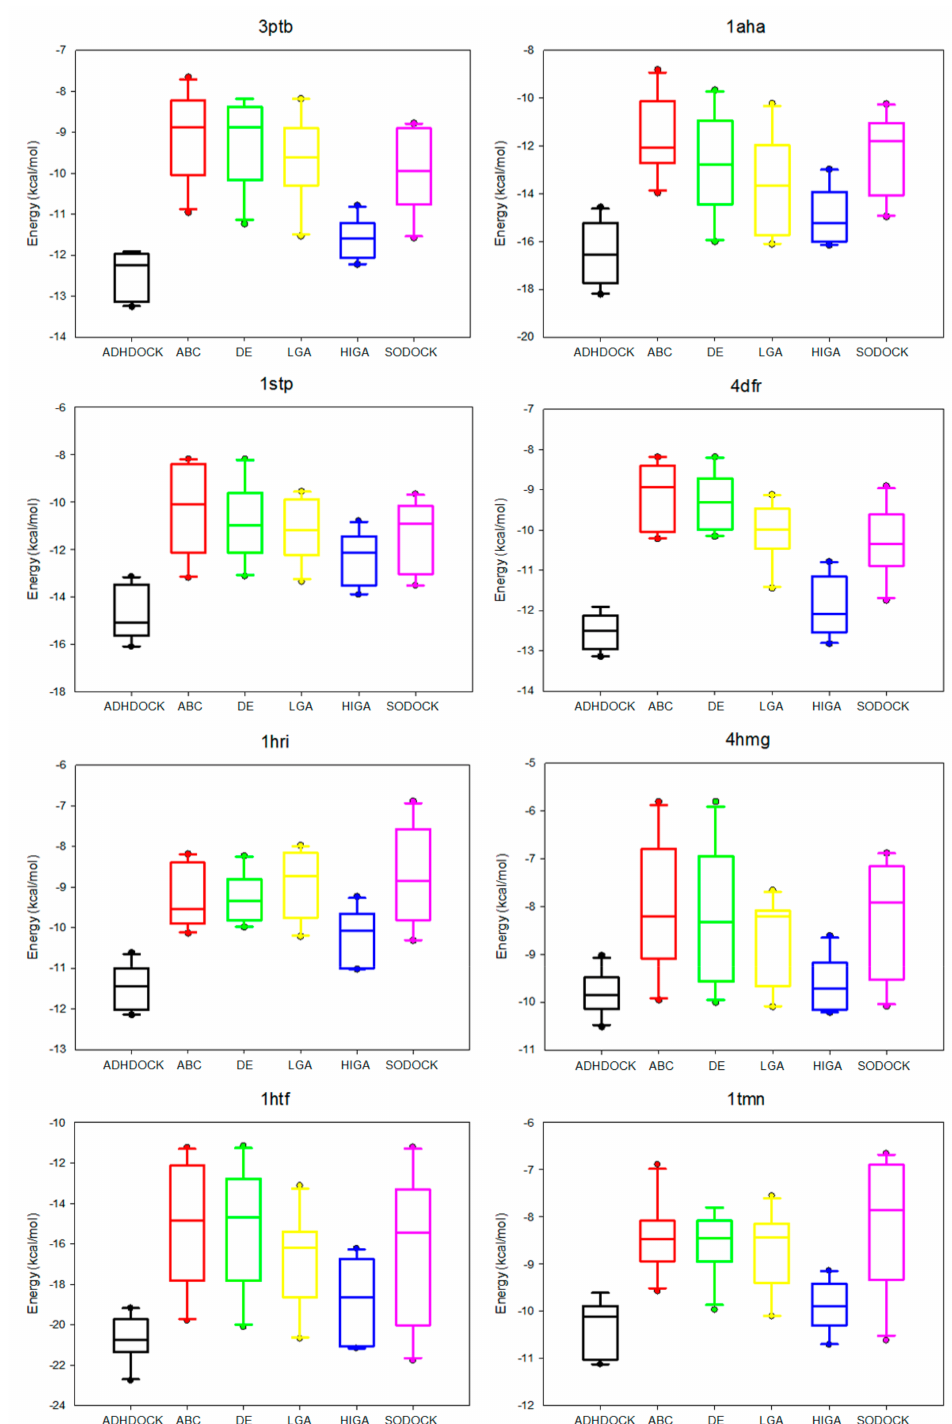
Figure 3. Box plots of six tested